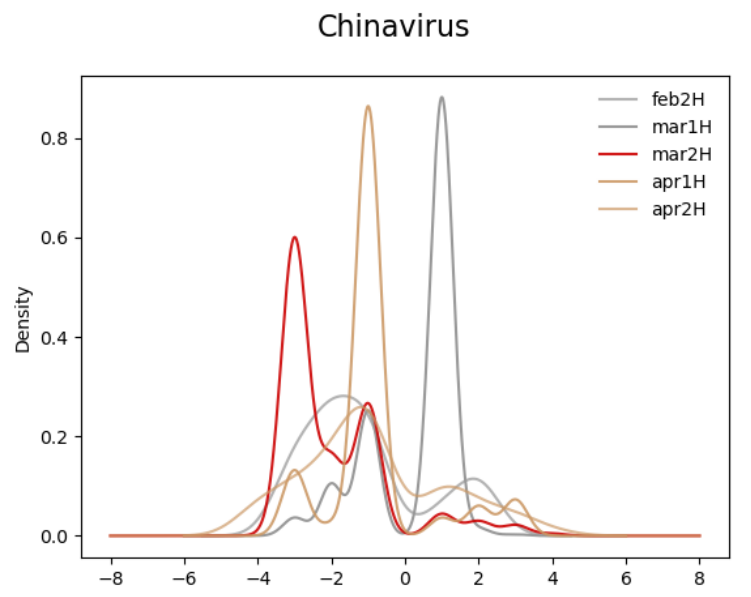
Figure 4. Sentiment score distribution of Word2Vec terms with cosine similarity score of at least 0.3 compared to